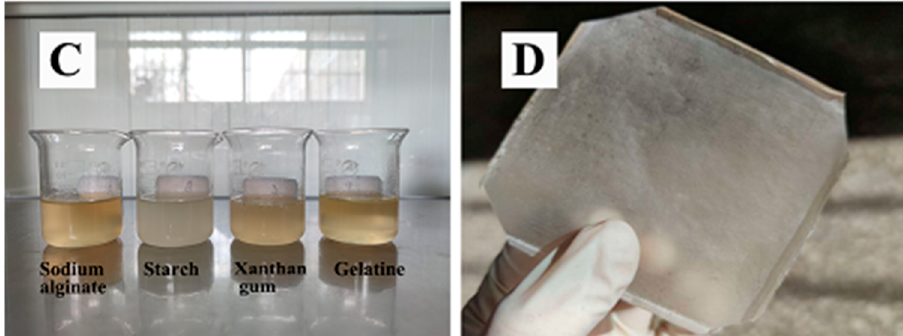
Figure 1. ( A ) Examples of BC (Contains water), ( B ) Sodium alginate, starch, xanthan gum, and gelatin, ( C ) Composite film solution, ( D ) CMBC/SA/GL composite film.